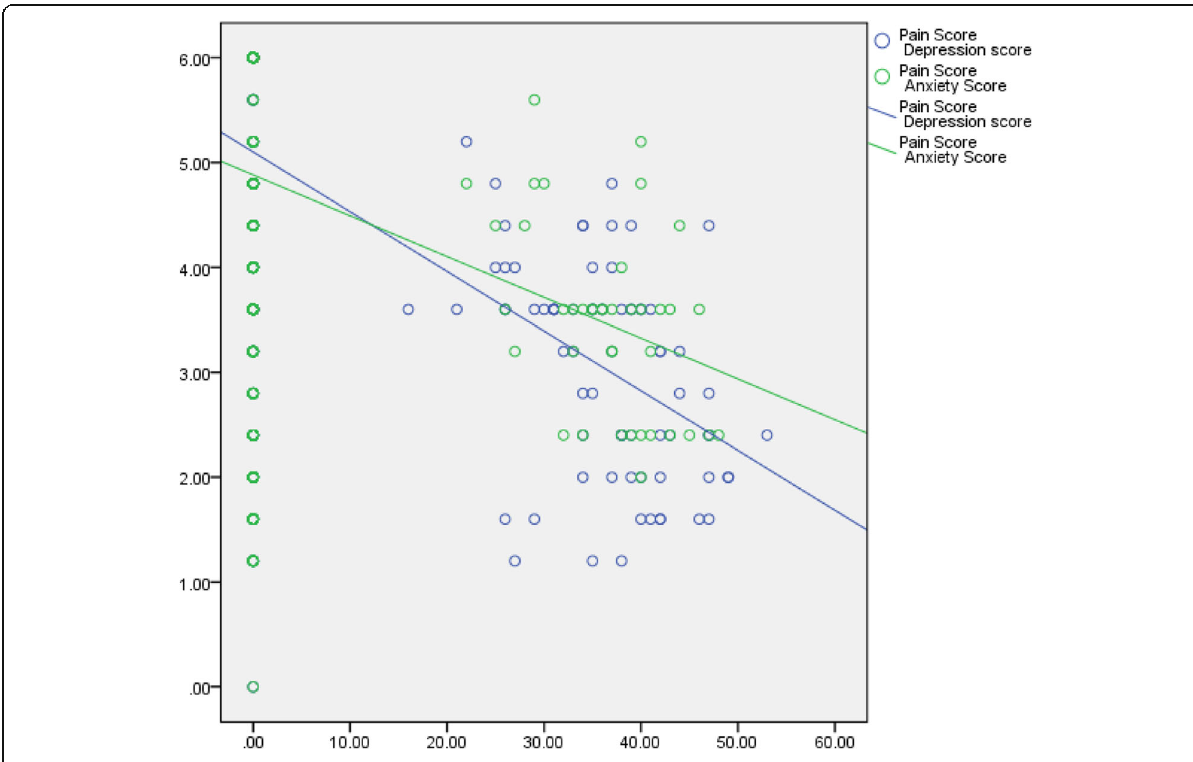
Fig. 2 Overlay scatter plot for pain score with depression score and anxiety